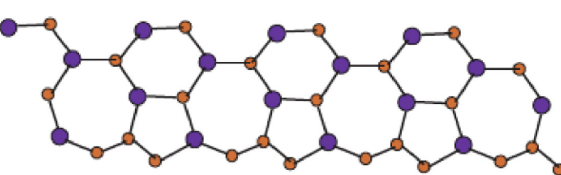
Figure 3: Sheet of Si